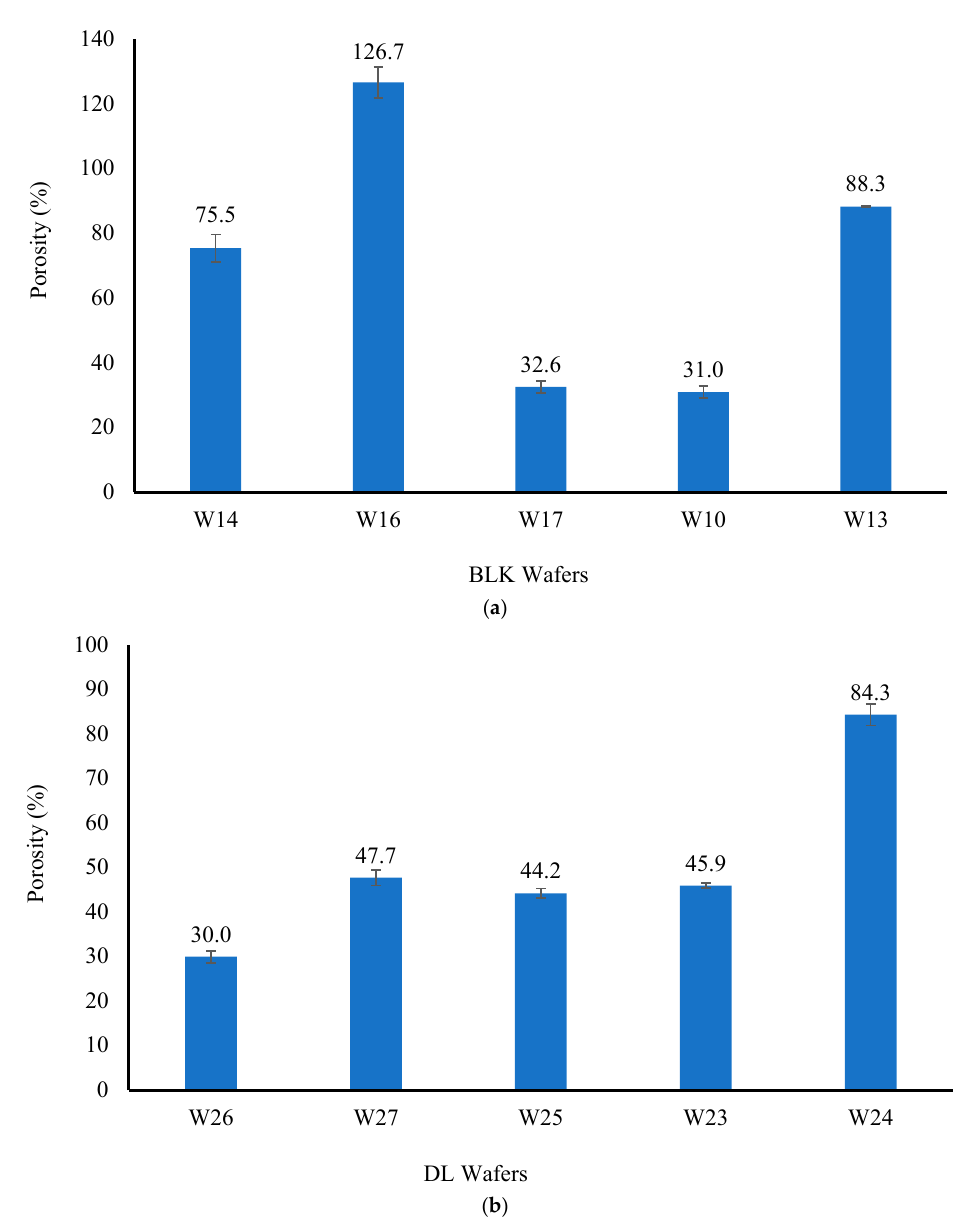
Figure 5. The porosity (%) profiles of BLK ( a ) and DL ( b ) wafers. For the BLK W14 and W16 wafers, the loading of MTz decreased the porosity, while drug loading increased the porosity for the W10, W13, and W17 wafers. It was observed that as the concentration of CARR in the wafers increased (W26 and W27), the % porosity also increased. The highest porosity (%) of the DL wafers was for W24, with a value of 84.3 ± 2.4% due to a higher concentration of SA and a low concentration of CARB, and interestingly, its corresponding BLK wafer had the second highest porosity. The porosity profiles did not directly correlate with the SEM micrographs, which is because SEM shows surface porosity and not internal interconnections. Unlike W24, the porosity results for W25, W26, and W27 appeared to be independent of the composite polymers used, which might be due to the blockage of pore capillaries by MTz, therefore causing the solvent to penetrate less effectively. A statistical analysis of the % porosity for the DL wafers (W23 and W27) showed a significant difference ( p < 0.05) between them. This may be attributed to the increase in the total solid (polymer and drug) content for W25, which increased in viscosity due to the higher density of the